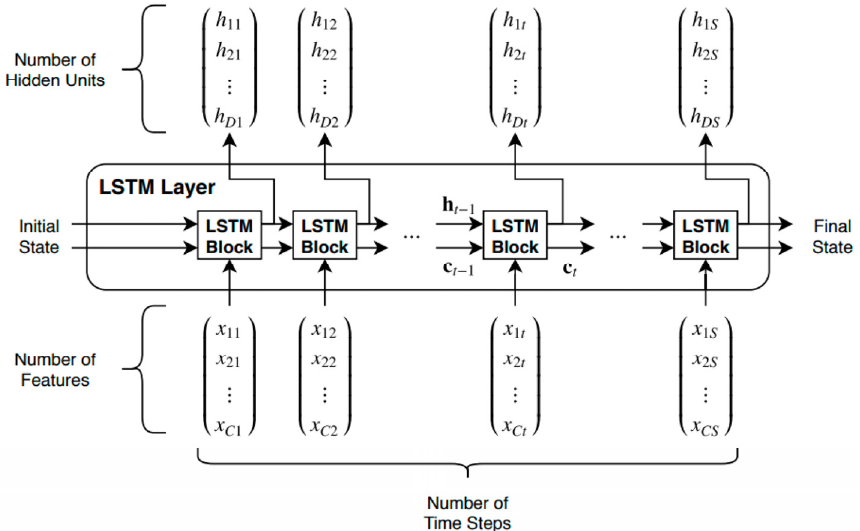
Figure 5. Data flow chart in the processing and representation time series X with C feature channels of length S in an LSTM network.